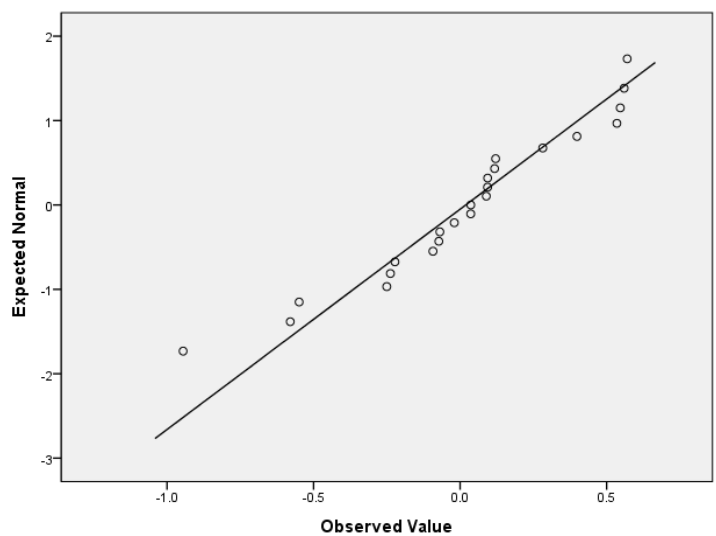
Figure 2. Normal plot for